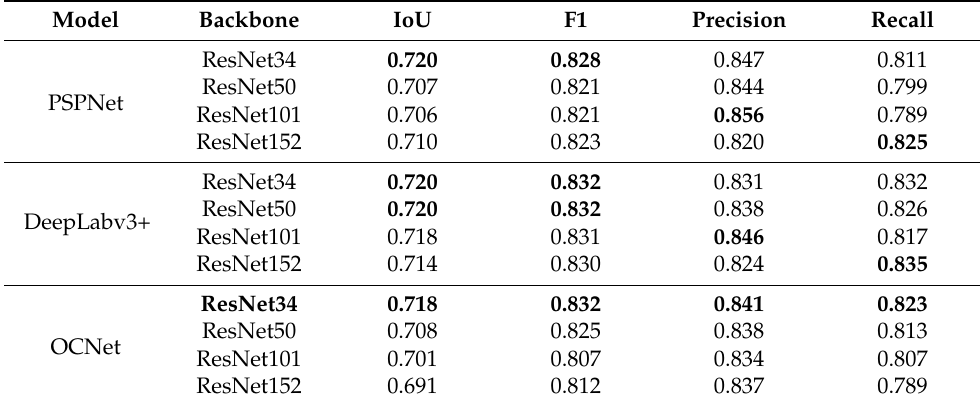
Table 4. Model performance for different backbones.